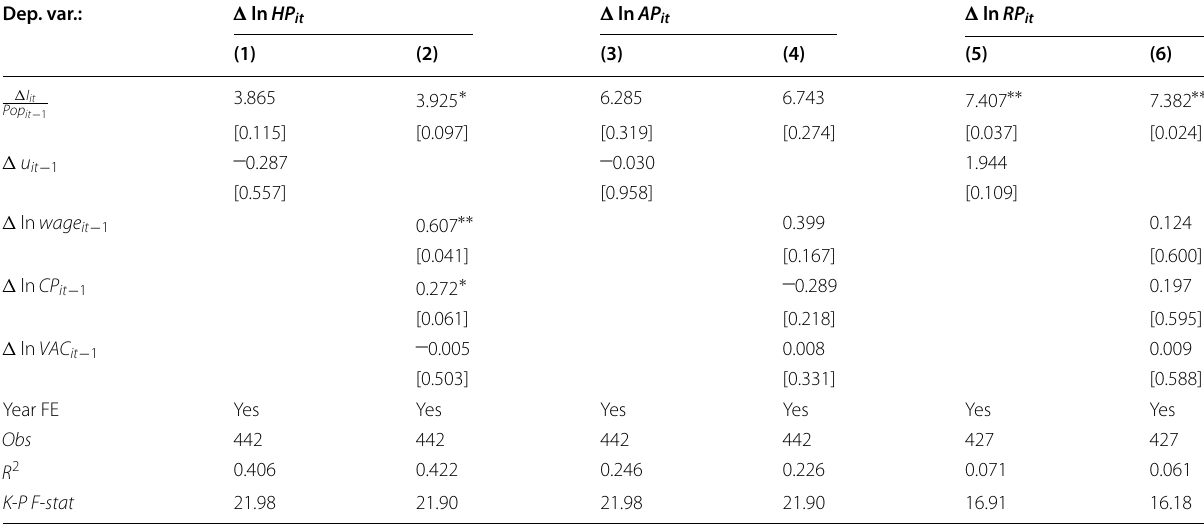
Table 7 Housing prices and immigration—cantons from 1998–2016: IV regressions. Source: Own calculations based on data from Wüest Partner and Federal Statistical